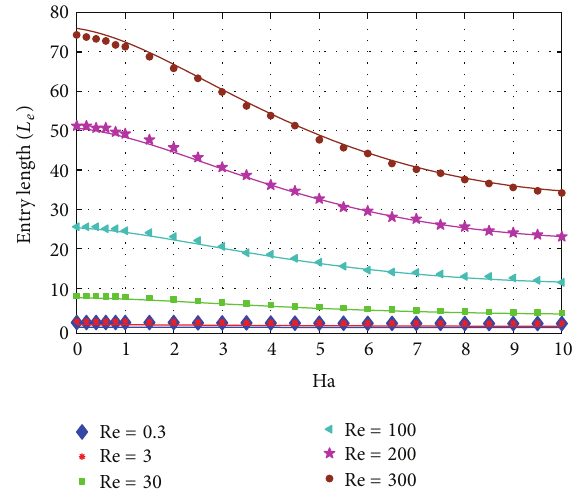
Figure 5: Steady entrance length in terms of the Hartmann number Ha and Reynolds number Re. (Entry length indicated by points obtained from numerical solutions and solid lines represent the theoretical